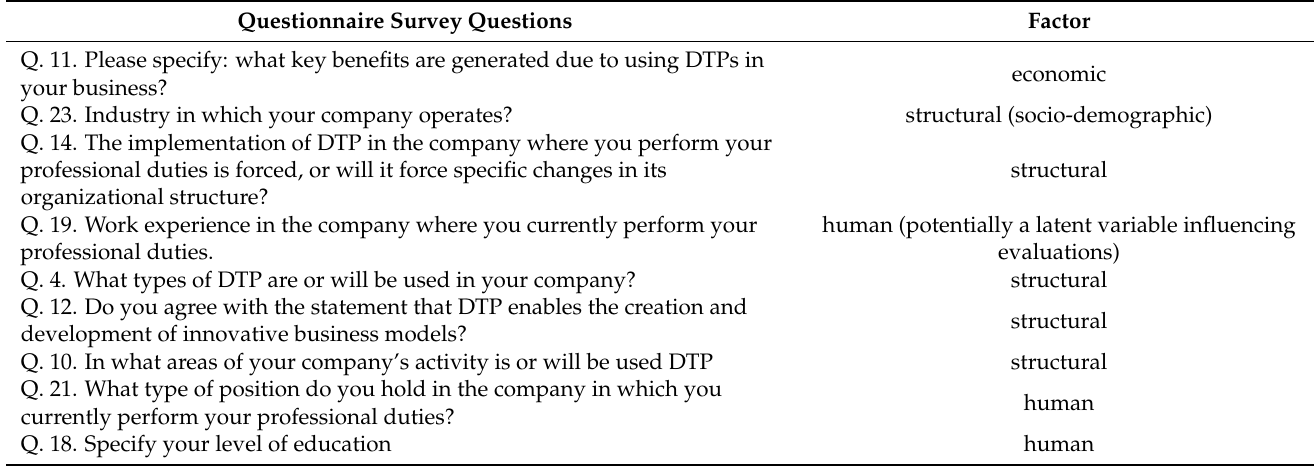
Table 1. Variables used to construct the model of attitudes towards